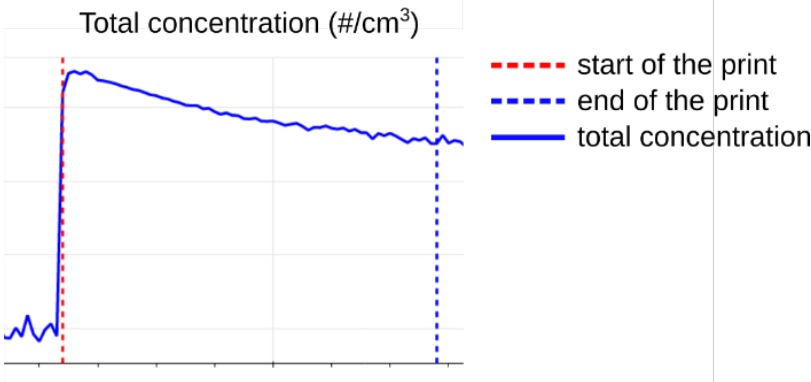
Figure 5. Prevalent progression of total particle concentration during the printing of PET-G. This peak in particle concentration indicates rapid nucleation processes, which occur during the first minutes of printing inside the particle-free chamber. The peak of the distribution was at this moment very sharp, located in the nano-particle range commonly between 8 to 40 nm. Figure 6 shows the maximum total particle concentration for all measured materials, temperatures, and nozzle